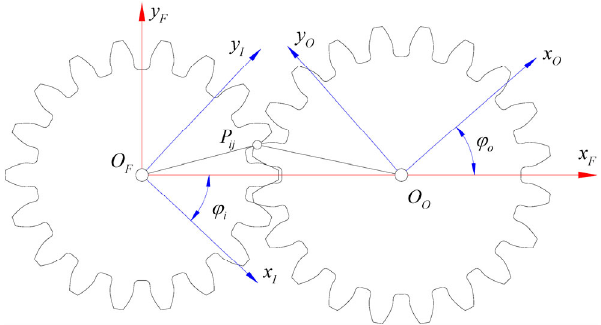
Fig. 3 Coordinate systems for calculation of the contact